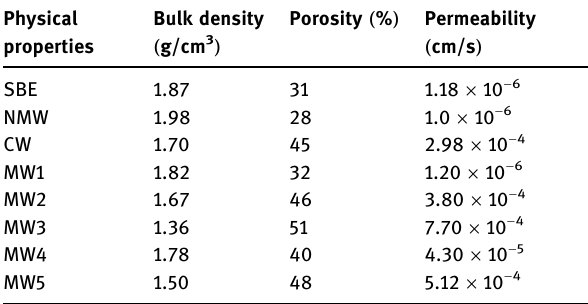
Table 3: The physical properties of the soil before and after